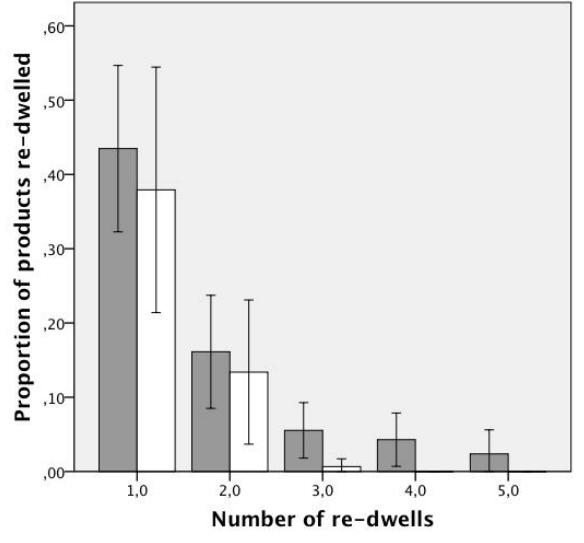
Figure 7. Proportion of products re-dwelled once, twice and so forth in the second stage of the Natural Decision Segmentation Model. Grey bars represent decision task and white bars repre- sent search task. Error bars +/- 2